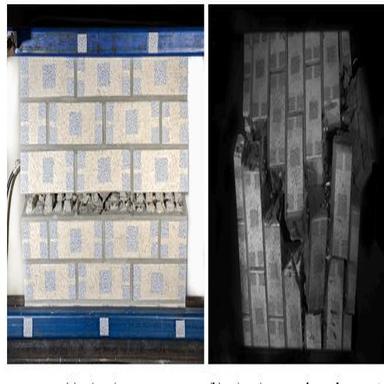
Bending failure in direction e1 and e2 .